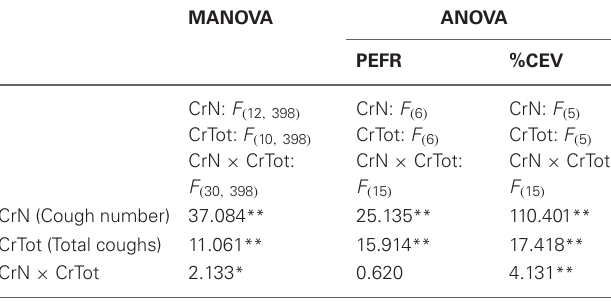
Table 2 | Multivariate (MANOVA) and Univariate (ANOVA) analyses of variance F ratios for CrN × CrTot effects for PEFR and